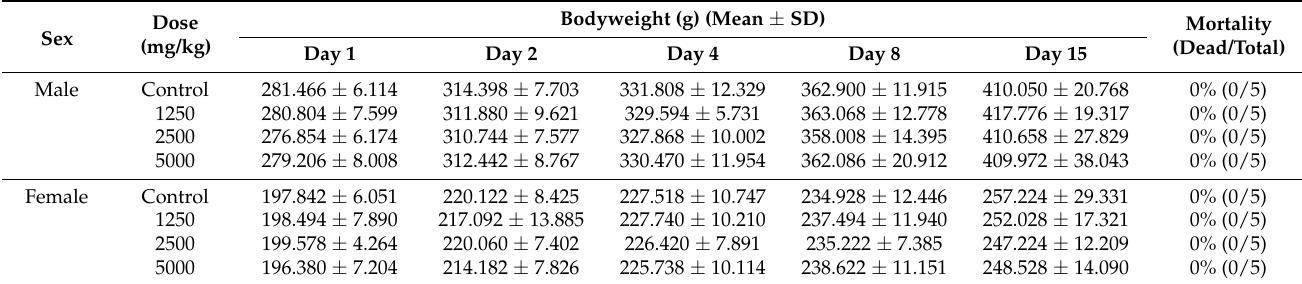
Table 1. Bodyweight and mortality in single oral dose toxicity of WG extract.